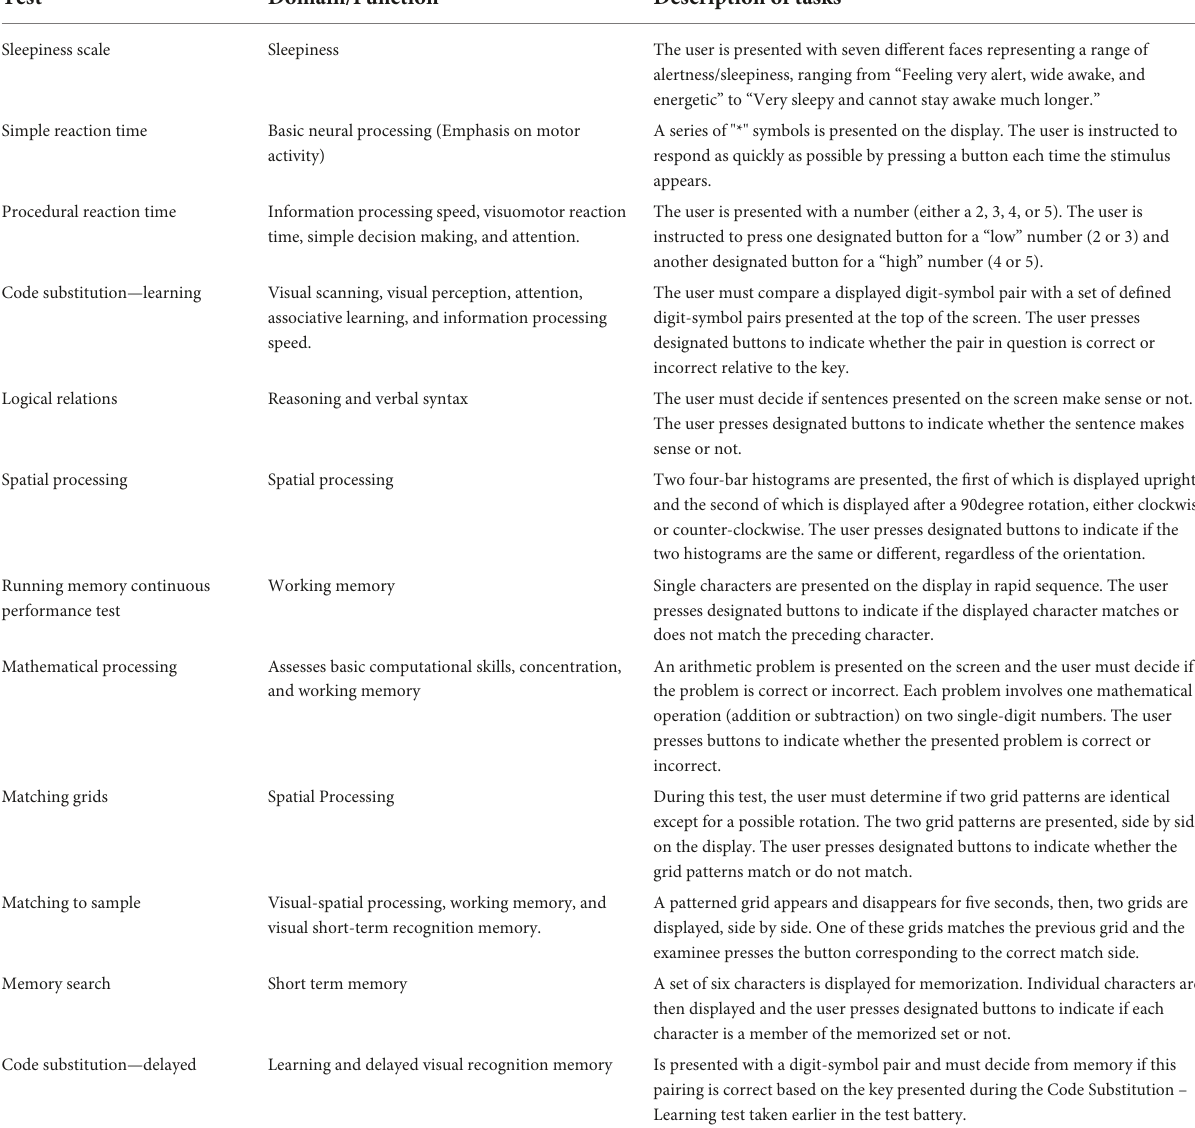
TABLE 1 Ped-ANAM subtests and their functions in order of